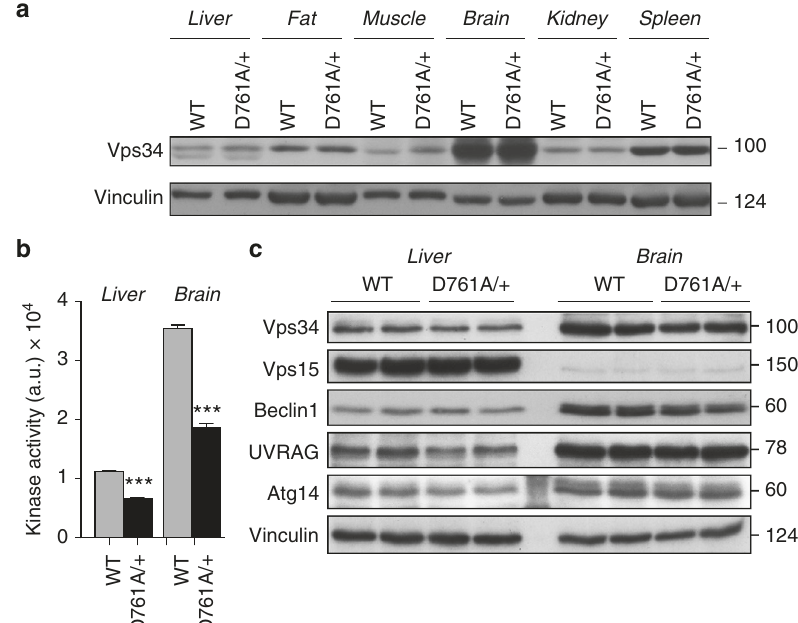
Fig. 1 Characterization of Vps34 D761A/+ mice. a Expression of the Vps34 protein in WT and Vps34 D761A/+ mouse tissues. 100 µ g of protein was loaded per lane. Representative data from three independent experiments. b Lipid kinase activity associated with Vps34 in WT and Vps34 D761A/+ mouse tissues. Tissue and cell homogenates were immunoprecipitated with an anti-Vps34 antibody, and an in vitro lipid kinase assay was performed using PI as substrate. Data represent mean ± SEM (non-parametric Mann – Whitney t -test) * p < 0.05, ** p ≤ 0.01, *** p ≤ 0.001. 4 mice/genotype. c Expression levels of Vps34 and its binding partners in liver and brain tissues of 12-week-old mice. Tissue/cell lysates were immunoblotted using the indicated antibodies. 60 µ g of protein was loaded per lane. Composite images are derived from experiments whereby equal amounts of the same cell/tissue extract were loaded on separate gels and developed with the same indicated antibodies. This was done to quantify proteins with a similar molecular